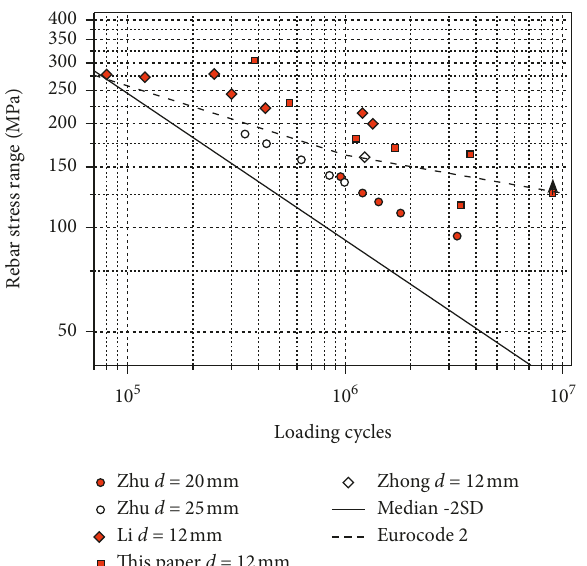
Figure 14: S-N curve comparison between equation (3) and Eurocode